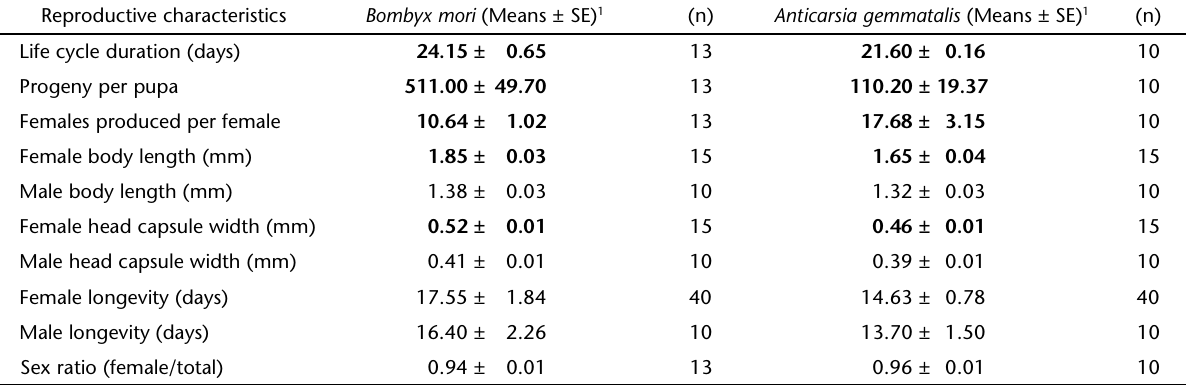
Table I. Reproductive characteristics (mean ± standard error) of P. elaeisis when reared on pupae of B. mori or A. gemmatalis .